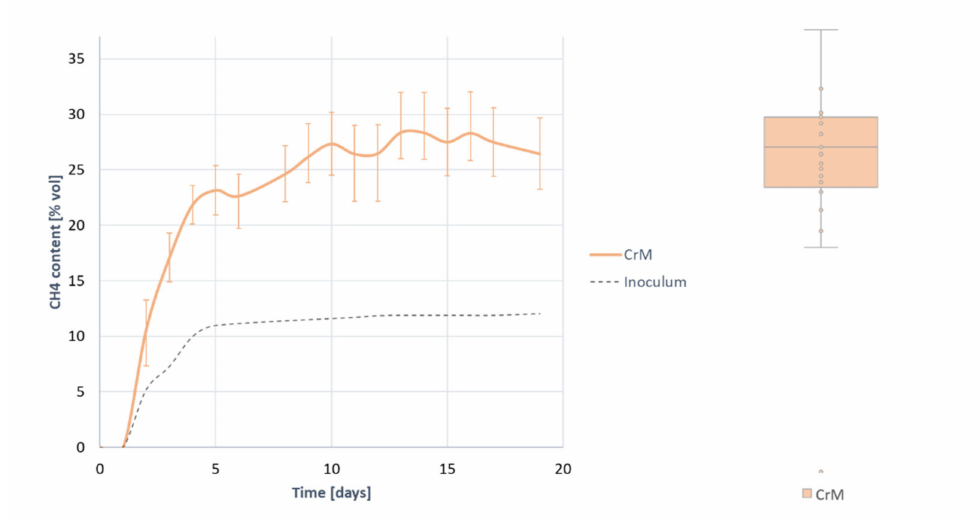
Figure 3. Methane content mean curve from the biogas produced in the anaerobic digestion of 100 g of residue CrM and box diagram of its variation.